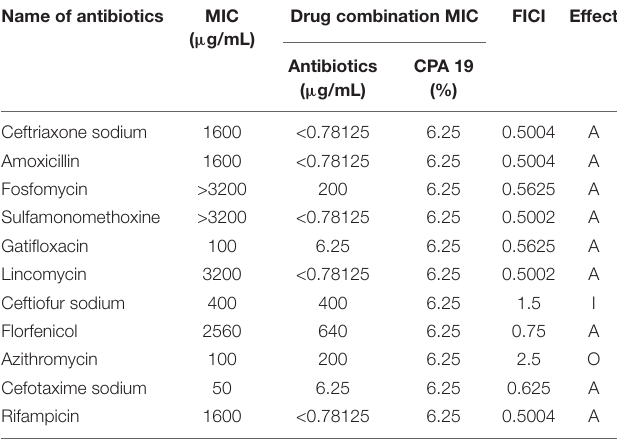
TABLE 5 | The FICI of CPA 19 with antibiotics